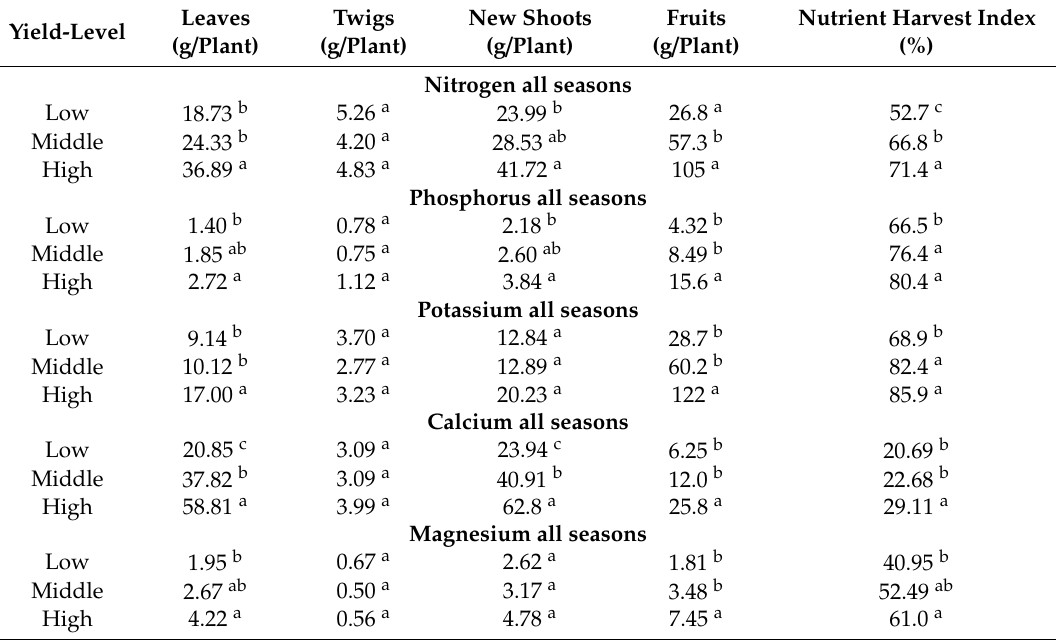
Table 3. Nutrient accumulations in leaves, twigs and fruits, and nutrient harvest indexes under di ff erent yield levels. The di ff erent letters (a–c) in the table represent significant di ff erences ( p < 0.05) among